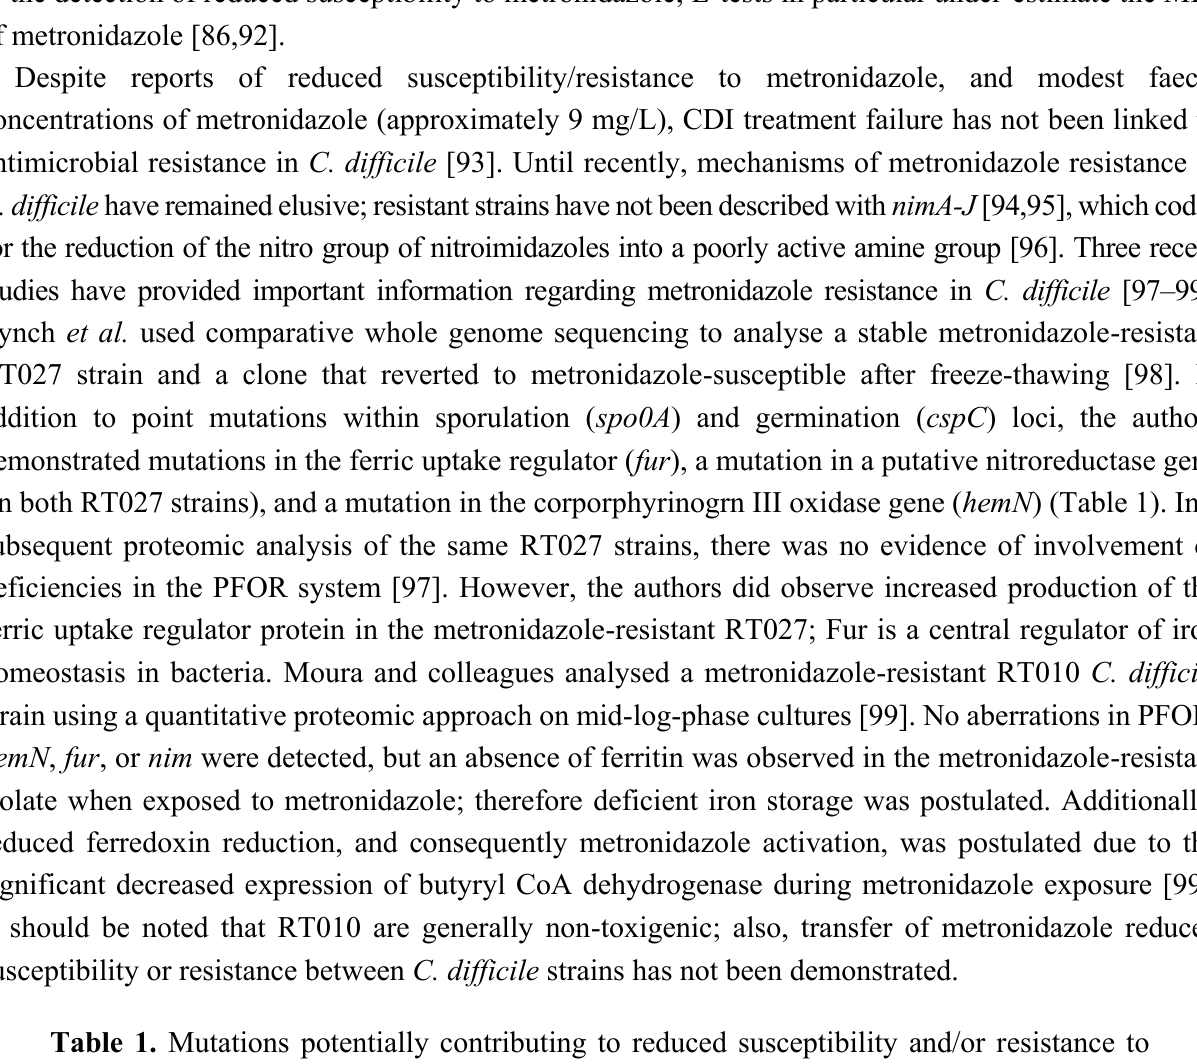
Table 1. Mutations potentially contributing to reduced susceptibility and/or resistance to metronidazole (MTZ) in C.